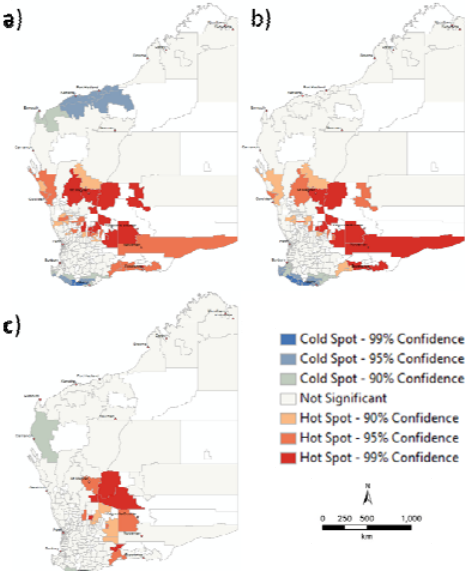
Figure 4. PHC hotspot analysis relative to a) State, b) ARIA- based regions and c) Health